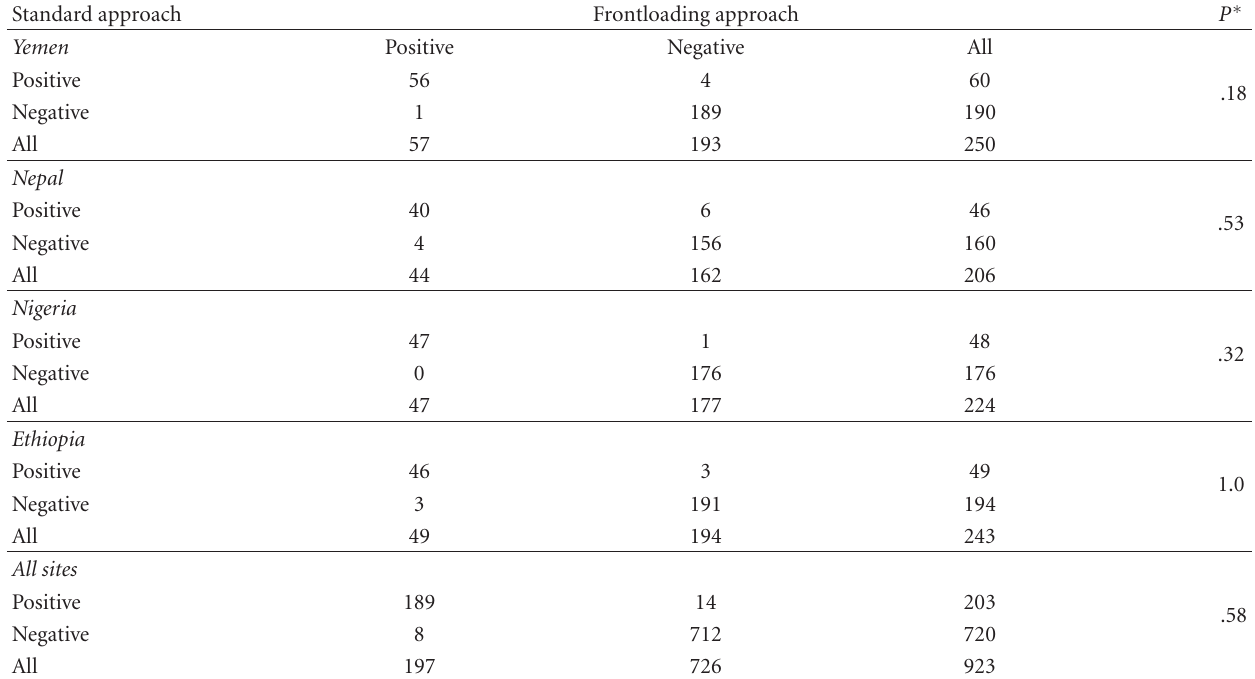
Table 3: Yield of two smears collected using the standard (spot-morning) and the frontloading (spot-Xspot) approaches by country. Standard